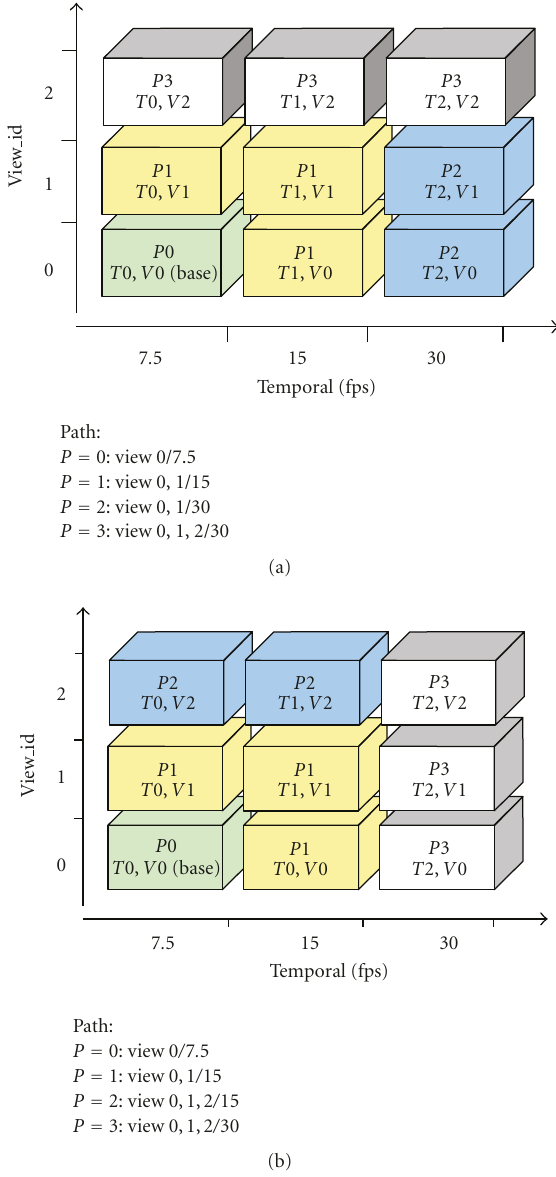
Figure 3: Assignment of priority id for NAL units of a 3-view bitstream with two levels of temporal resolution. T: temporal level; V: view identifier; P: priority identifier. Temporal level equal to 0 corresponds to 7.5fps (frame per second), it equal to 1 corresponds to 15fps, and it equal to 2 corresponds to